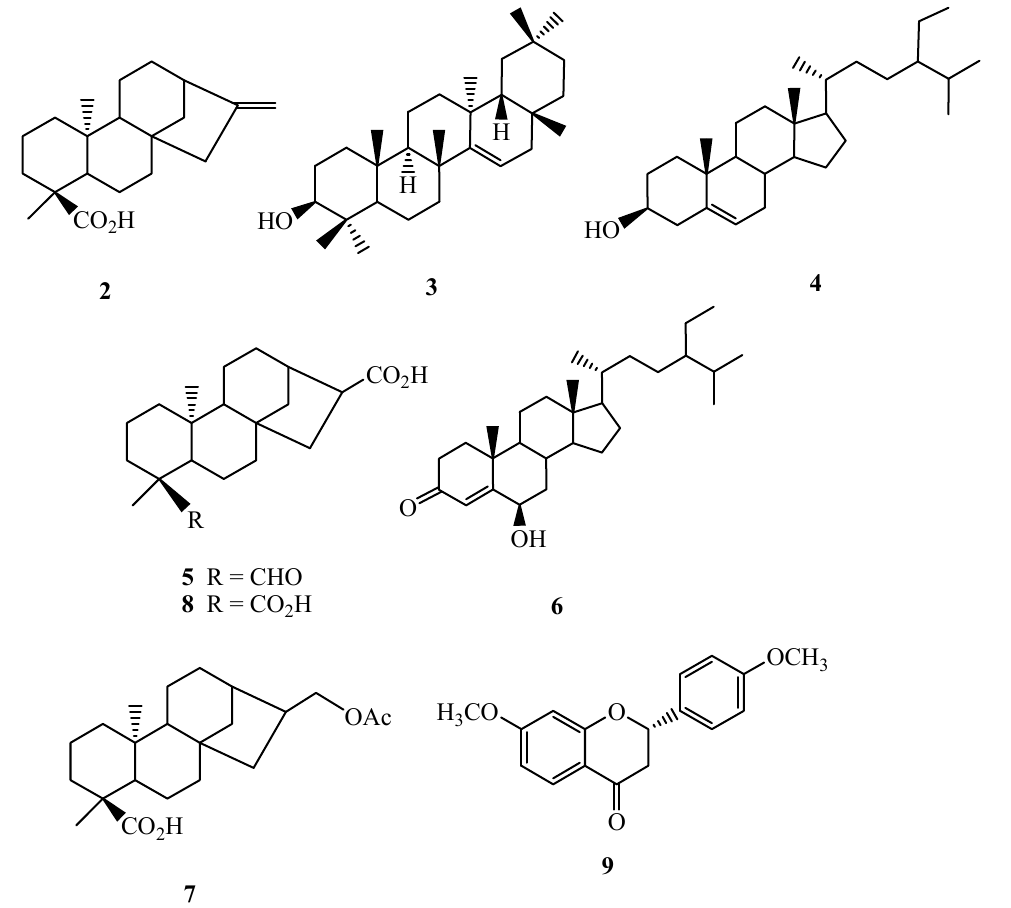
Figure 2. Structures of purified known compounds 2 – 9